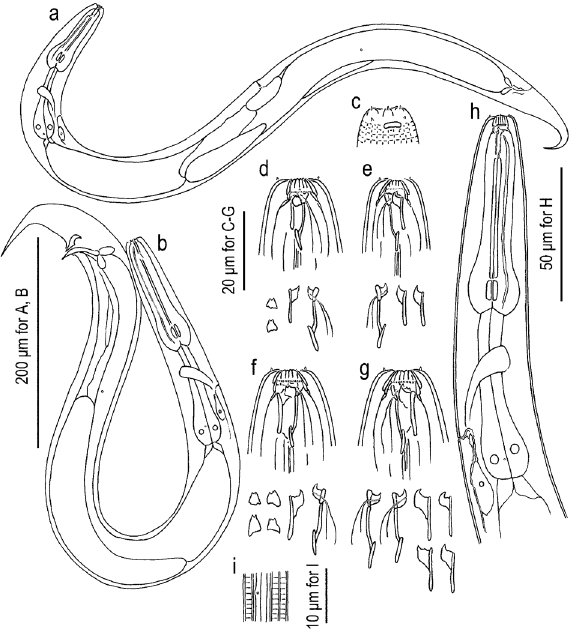
Figure 2. Onthodiplogaster japonica n. gen., n. sp. ( a ) Entire body of female in right lateral view; ( b ) entire body of male in right lateral view; ( c ) surface of lip region of male in left lateral view; ( d,e ) stomatal region of female feeding on Botrytis cinerea in left ( d ) and right ( e ) lateral views; ( f , g ) stomatal region of female feeding on Acrobeloides sp. in left ( f ) and right ( g ) lateral views; ( h ) pharyngeal region of female in left lateral view; ( i ) Body surface showing striation, lateral field and deirid in right lateral view. Left subventral ridge (with small triangular shape), right subventral and dorsal teeth (both form flag-like shape combined with telostegostomatal cylinder, and dorsal tooth with dorsal pharyngeal gland) are separately drawn below each subfigure ( d – g